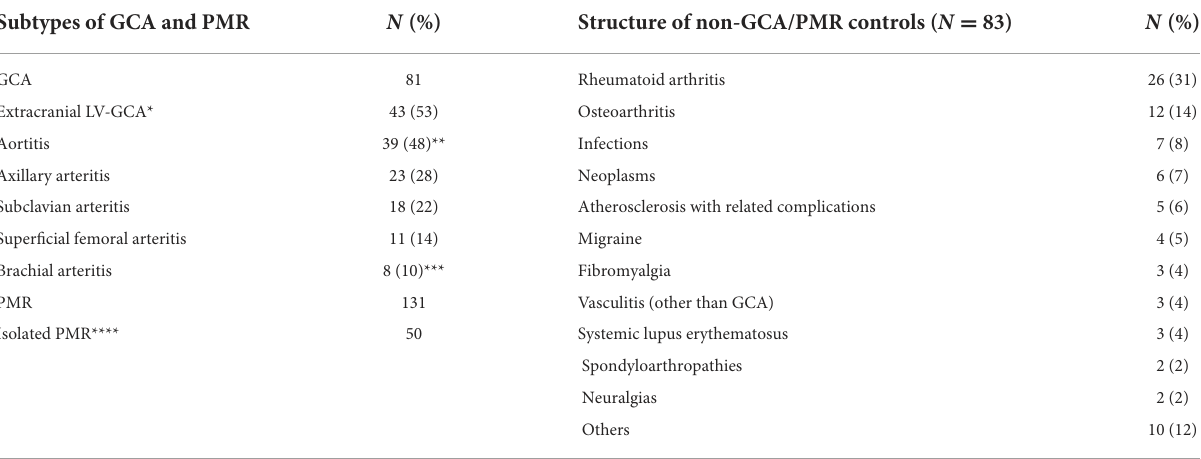
TABLE 1 Subtypes of GCA and PMR and structure of controls characterizing 214 included patients. Subtypes of GCA and PMR